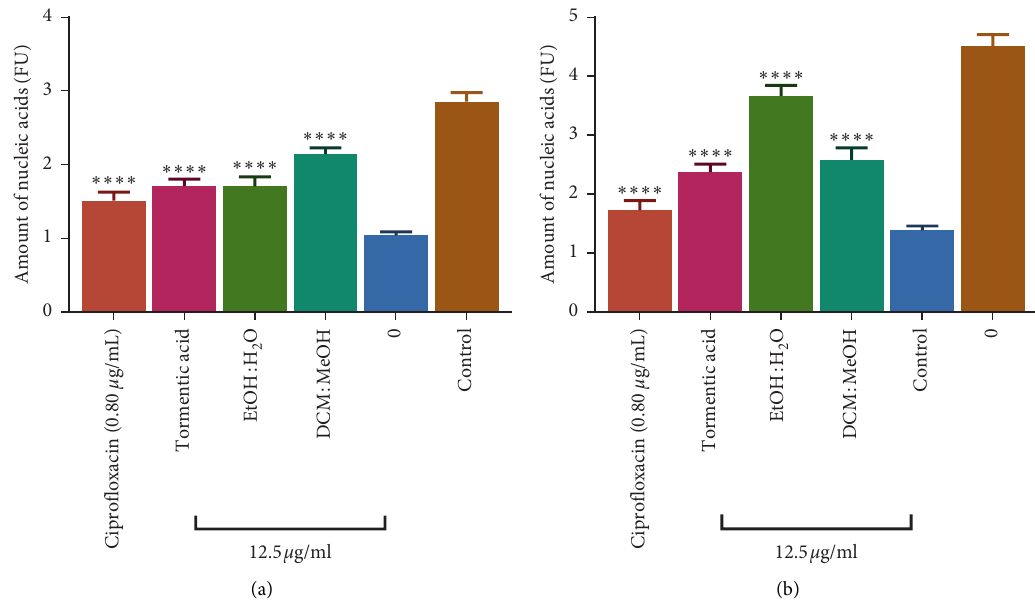
Figure 7: The effect of C. viminalis EtOH:H 2 O extract, DCM:MeOH extract, tormentic acid congener, and ciprofloxacin on extracellular DNA produced by P. aeruginosa (a) and S. aureus (b). Cells were incubated in a medium containing 0.80 µ g/ml ciprofloxacin as well as 12.5 µ g/ml of the crude extracts and tormentic acid congener for 72h. The amount of extracellular DNA present was determined by staining the biofilms with propidium iodide and spectrophotometrically measuring the amount of dye. These are results after a 24 well plate was washed with phosphate-buffered saline. ANOVA was carried out using GraphPad Prism6 and Dunnett’s multiple comparisons test with a summary of ∗∗∗∗ P value < 0.0001. Ciprofloxacin, tormentic acid congener, and extracts reduced extracellular DNA production in P. aeruginosa and S. aureus biofilms.